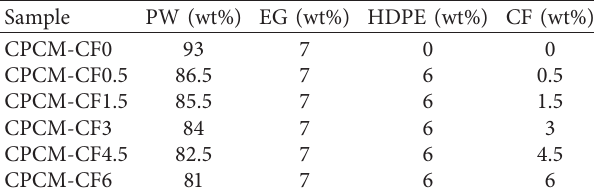
Table 1: The compositions of the PW/EG/CF/HDPE composites.